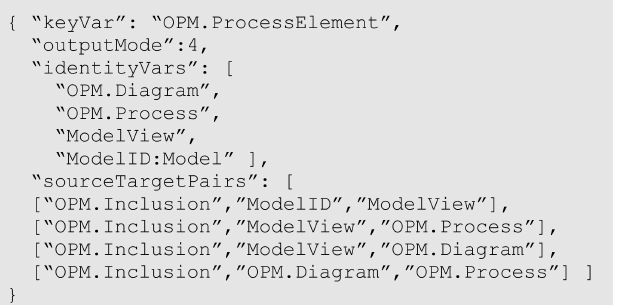
Figure 10. A JSON structure defining the required transformations of ProcessElement attributes to RSTUVCandidate items. This example does not include relationSourceTargetTriplets